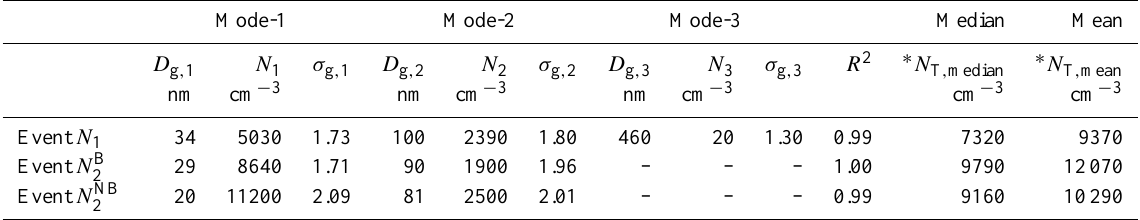
Table 6. Median number size distribution log-normal parameters of Events N 1 , N 2 – Breeze and N 2 – Non Breeze. The D g ,i , N i and σ I represent the geometric diameter, median number concentration and geometric standard deviation, respectively. The correlation coefficient ( R ) between observed and fitted size distribution is also shown. ∗ The median and mean total number concentrations ( N T , median and N T , mean ) are calculated from the measured values instead of the fitted